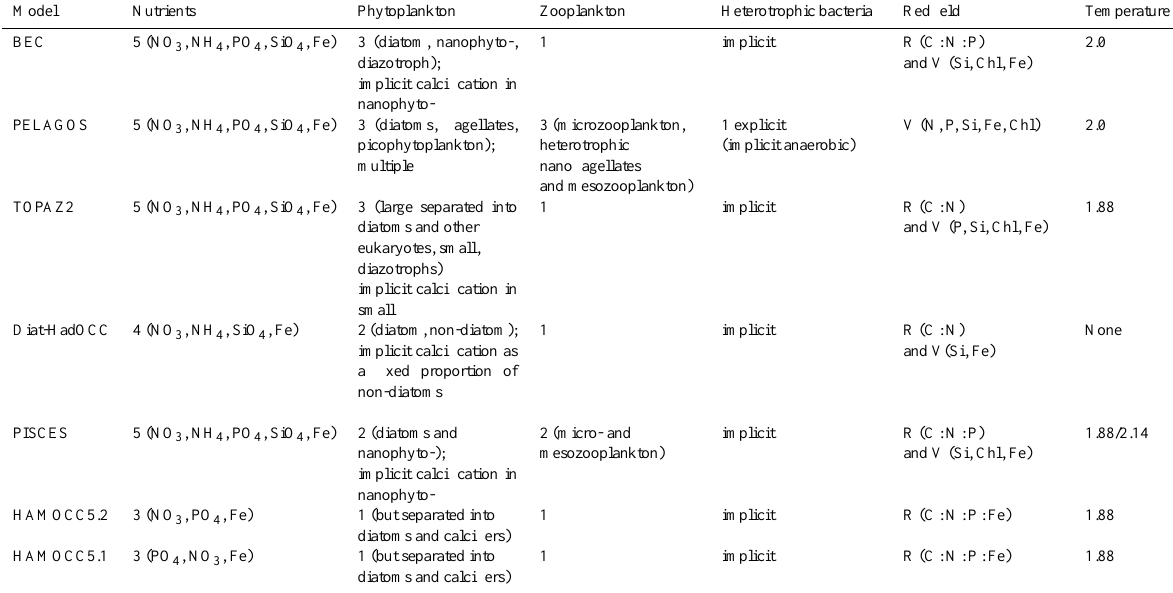
Table 1b. Main characteristics of the 7 marine biogeochemical components of the 10 ESMs used in this study: list of nutrients limiting phytoplankton growth, the number of explicit phytoplankton groups represented, the number of explicit zooplankton groups represented, explicit or implicit representation of heterotrophic bacteria, indications of the use of fixed Redfield (R) or variable (V) ratios for organic matter production, and Q 10 for temperature dependency of biogeochemical processes (autotrophic/heterotrophic when 2 numbers are given). Model Nutrients Phytoplankton Zooplankton Heterotrophic bacteria Redfield